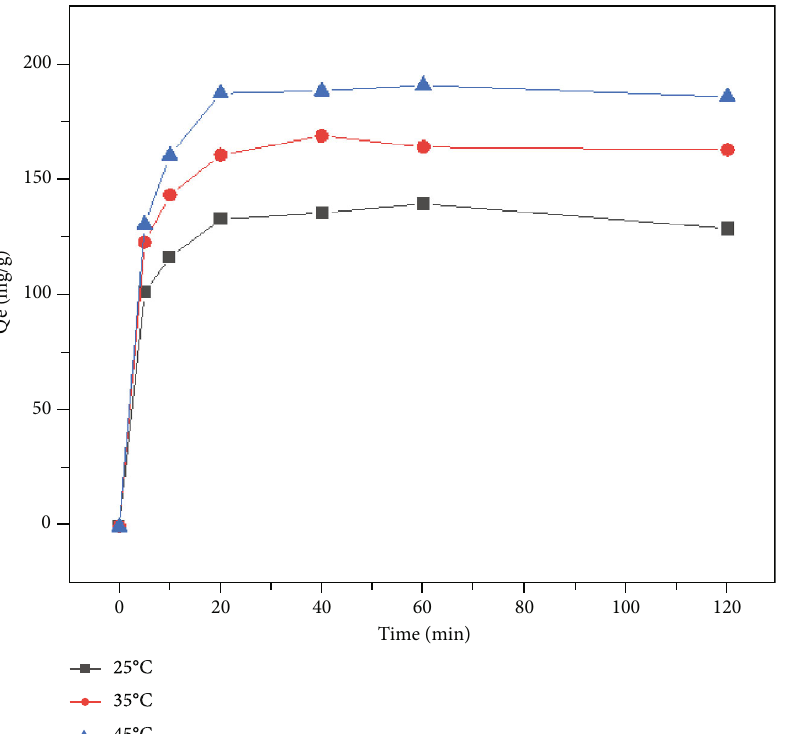
Figure 9: E ff ect of temperature and adsorption time value of solution on the adsorption of uranyl ions by CuFe